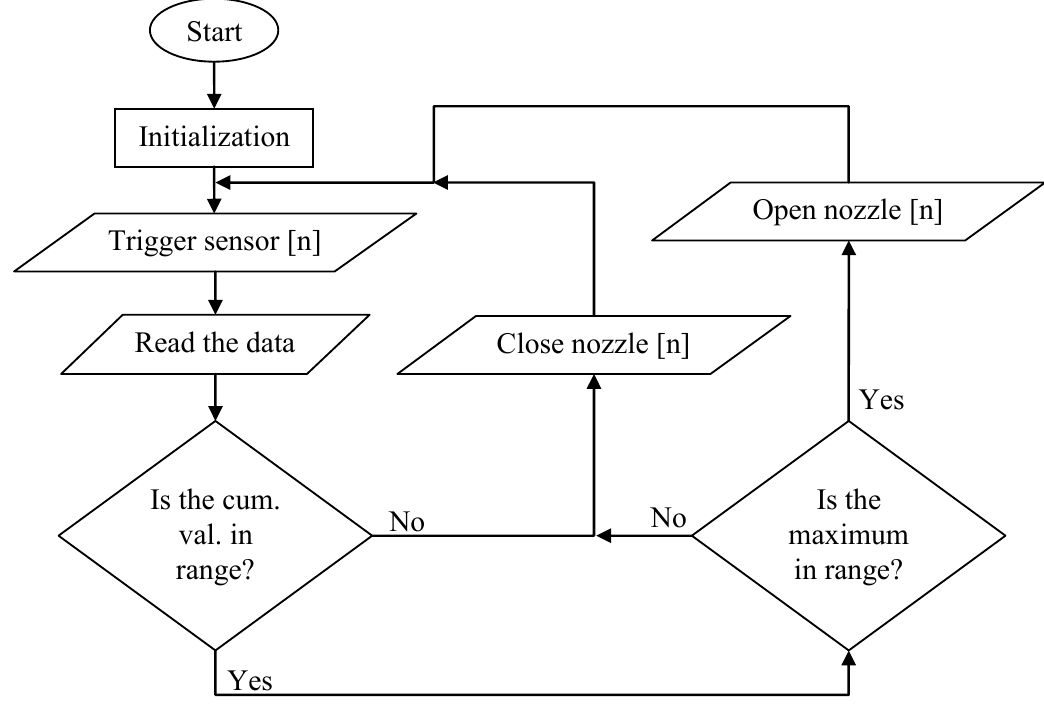
Figure 3. Simplified flow chart (without a delayed circular queue) of an algorithm running on the LPC1343